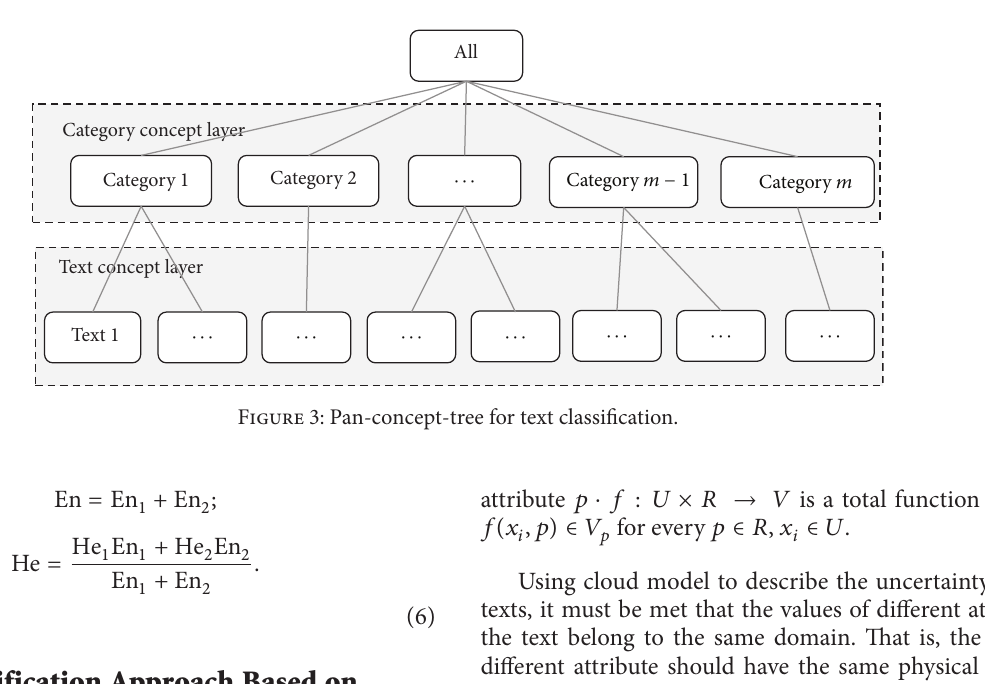
Figure 2: Cloud pan-concept-tree for person age distribution.